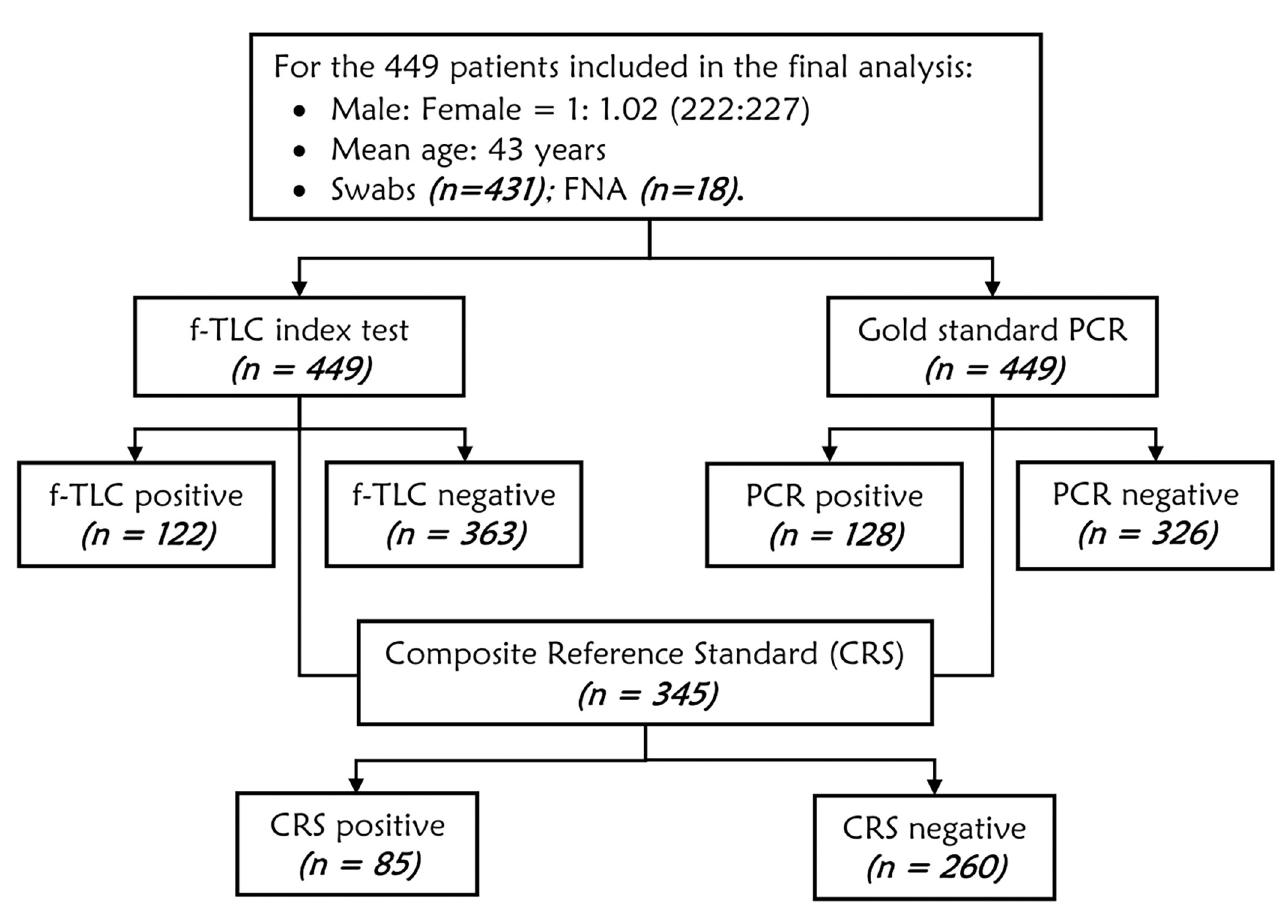
Fig 1. Flowchart of diagnostic tests performed on patients included in the final analysis.